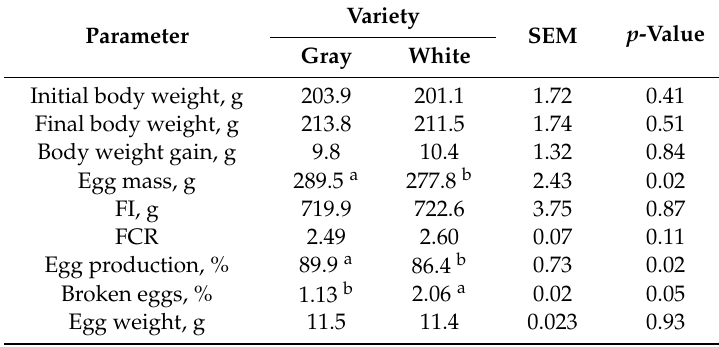
Table 1. Productive performance of two varieties of Japanese quails ( Coturnixcoturnix japonica